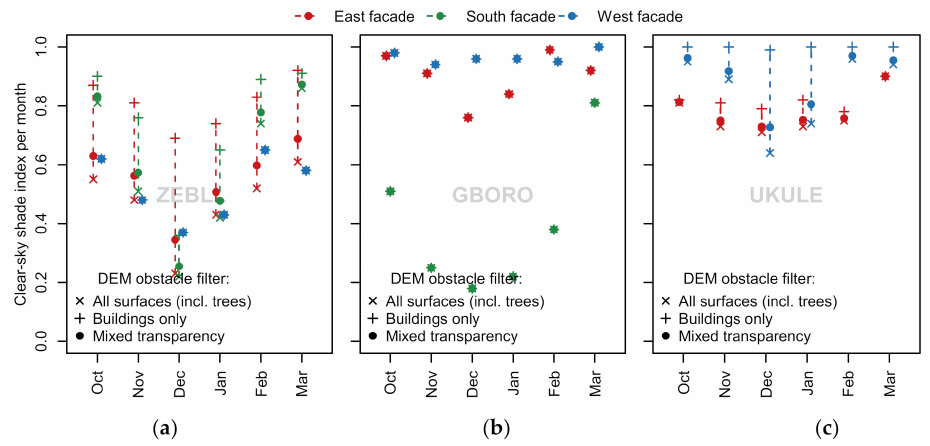
Figure 18. Monthly clear-sky shading index per façade for the winter months presented per façade from left to right: ( a ) ZEBLL ( b ) GBORO ( c )